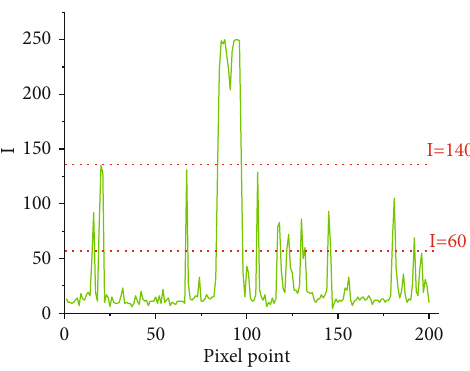
Figure 6: I value change curve on AA ’ scan